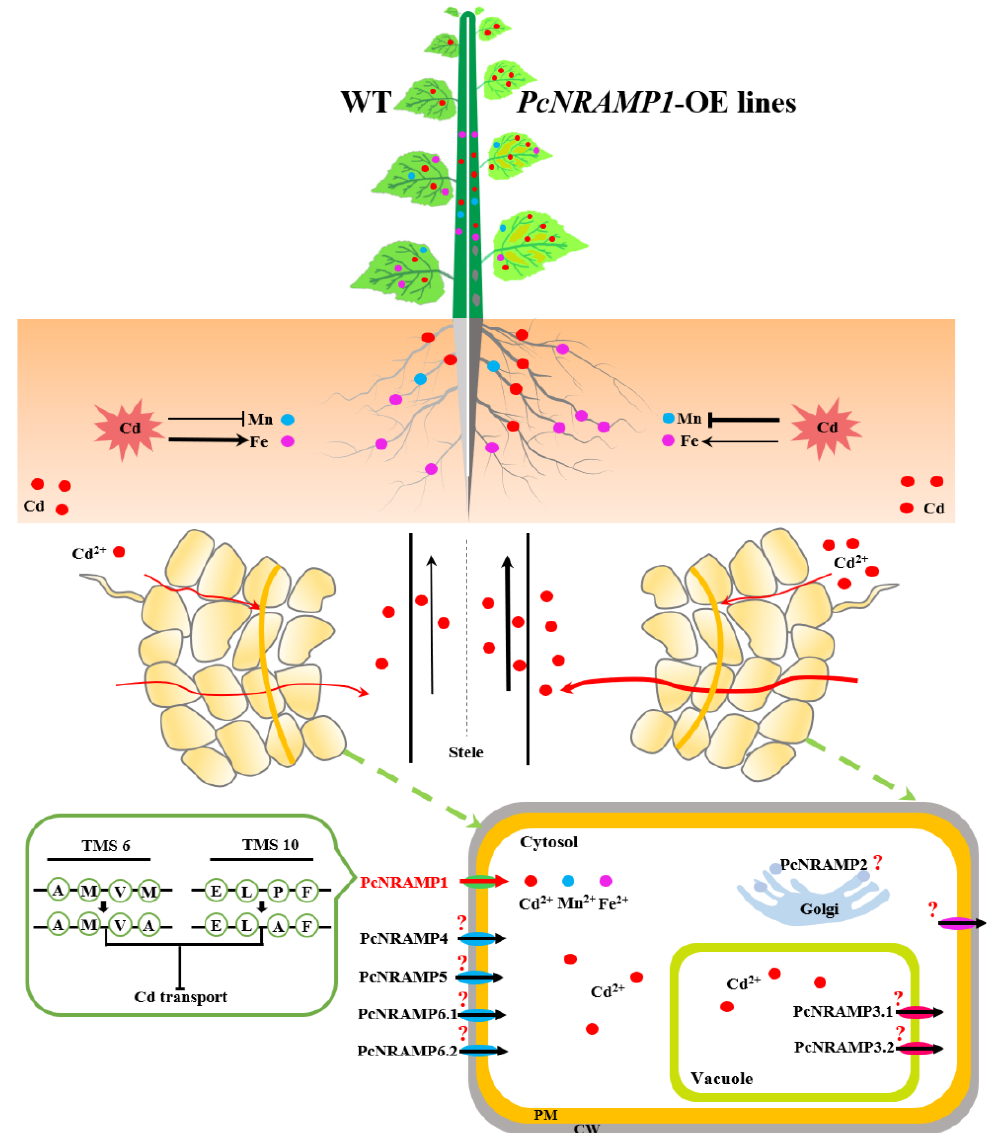
Figure 8. A schematic model illustrating PcNRAMP members and the molecular functions of PcNRAMP1 involved in HM uptake and transport of P. × canescens . TMS: transmembrane segments, PM: plasma membrane, CW: cell wall. : indicating the process is inhibited, : indicating the process is enhanced, and the thickness of both symbols indicates the relative strength of the process.